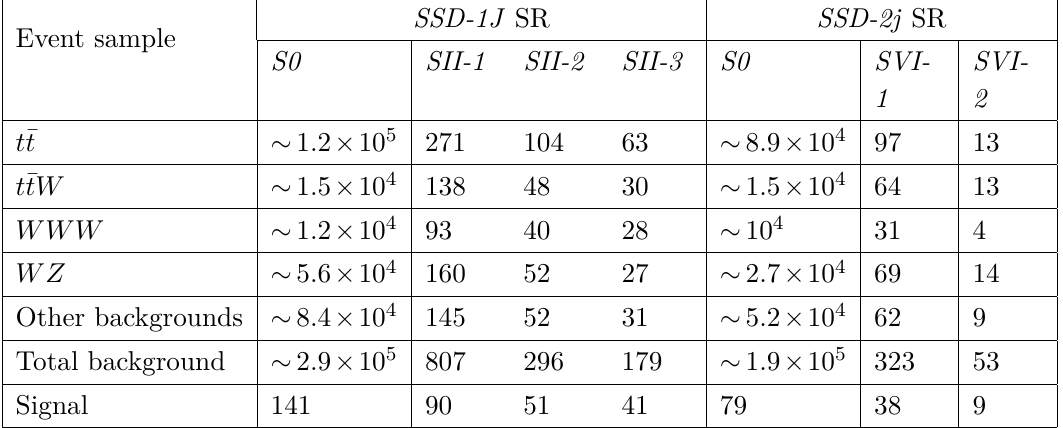
for 1000 fb − 1 of luminosity data at the 13 TeV 1